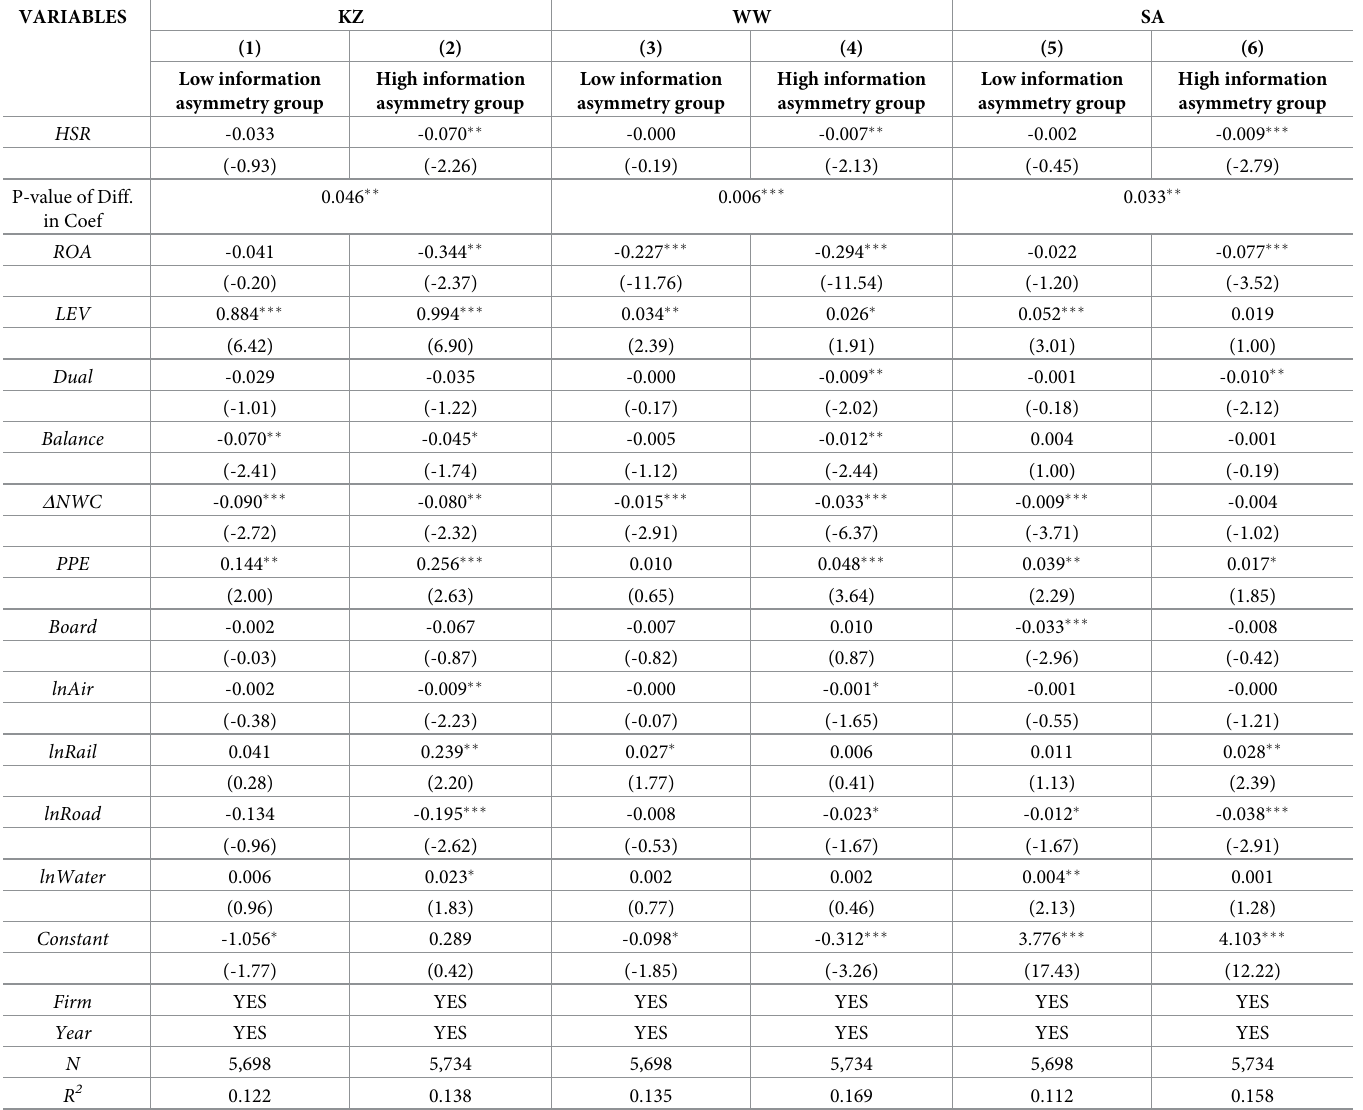
Table 12. Test results based on information asymmetry